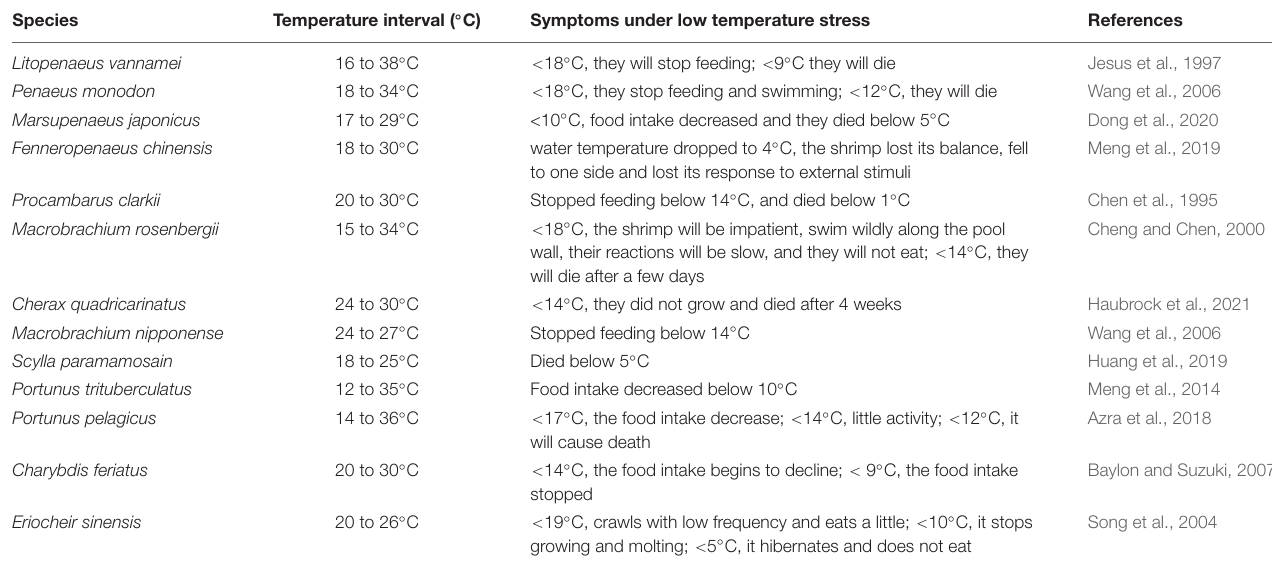
TABLE 2 | Tolerance and behavior characteristics of shrimp and crab in response to